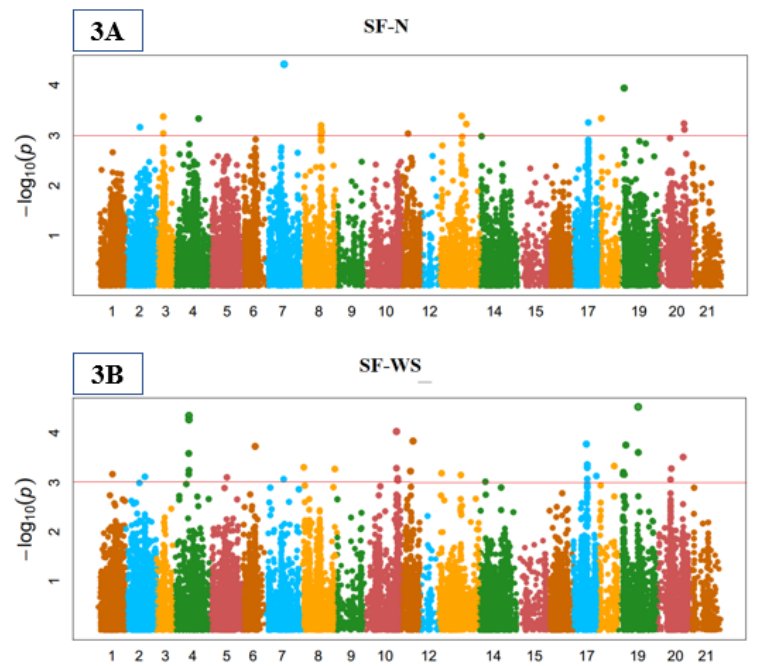
Figure 3. Manhattan plot of stomata frequency (SF) under normal (N) ( A ) and water shortage (WS) ( B ) conditions. Manhattan plots showing the location of significant SNPs and − log10( p ) associated with stomata frequency in bread wheat under normal and water shortage conditions. The red horizontal line on Manhattan plot entitles the threshold level ( p < 0.0001) of significance for SNPs with this trait.